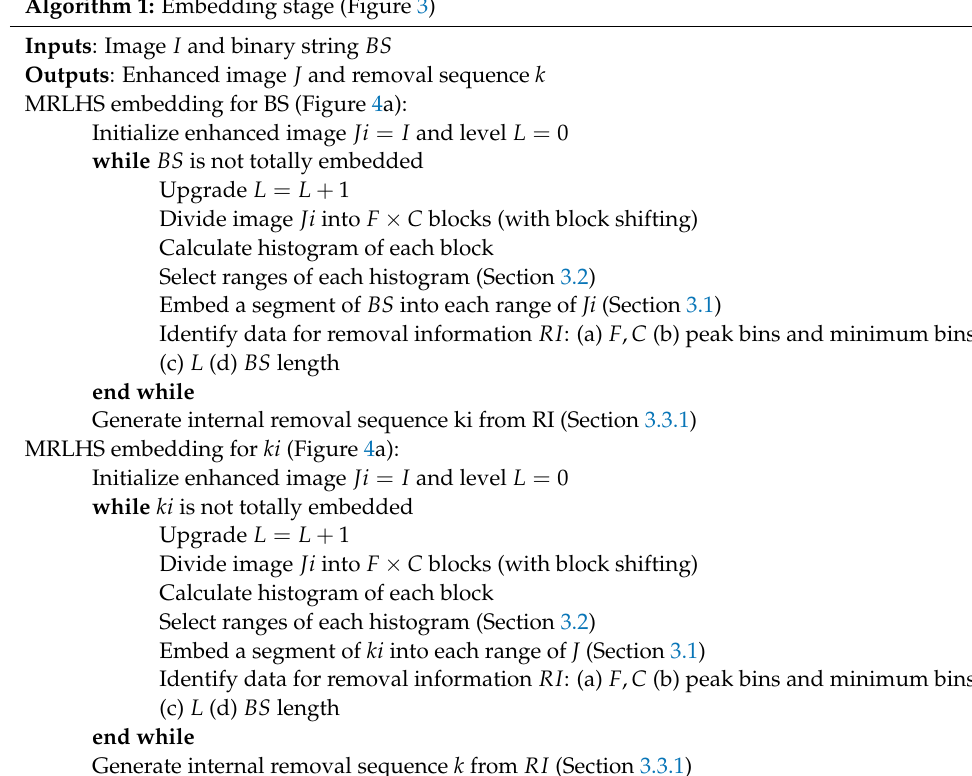
Algorithm 1: Embedding stage (Figure 3)